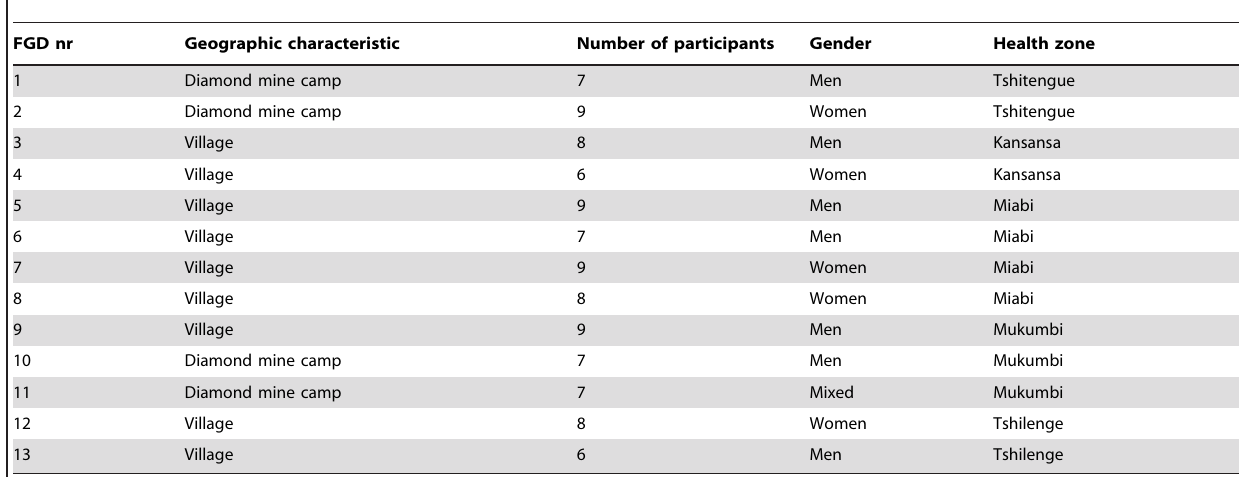
Table 2. Characteristics of the focus group discussions.